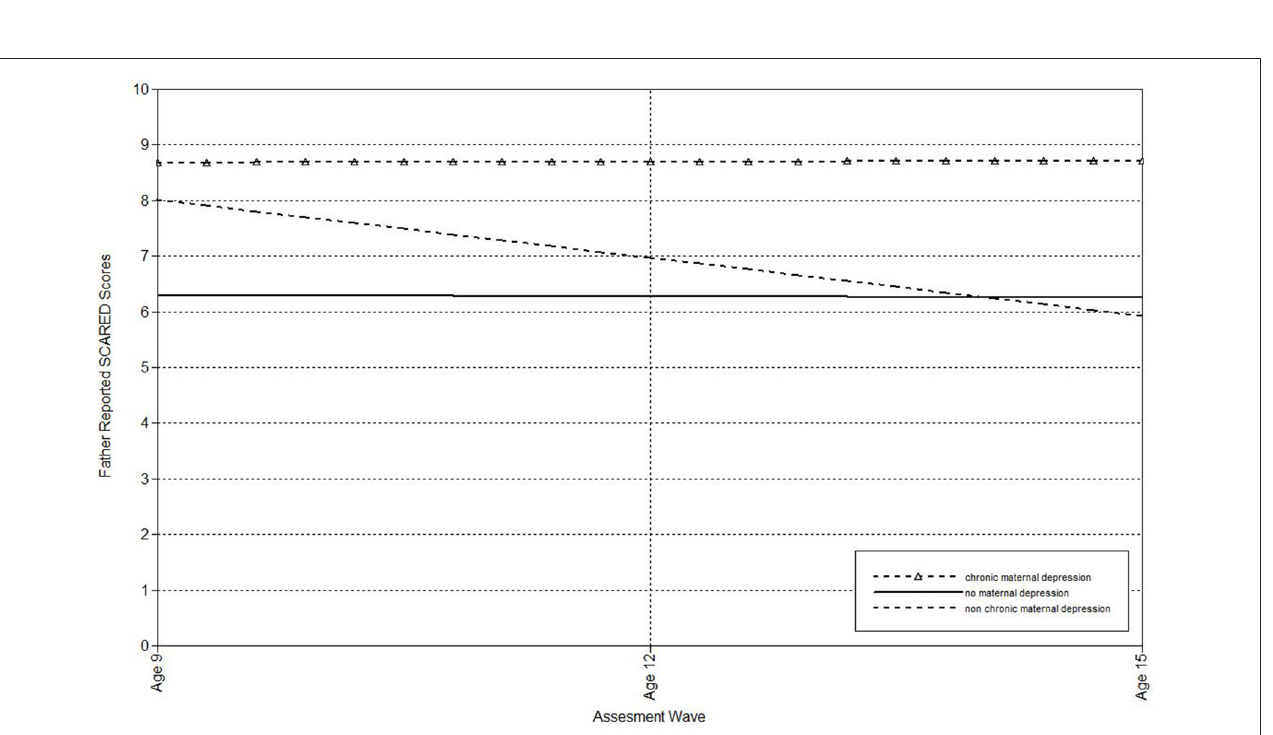
FIGURE 5 | Effect of non-chronic maternal depression (life-course perspective) on the slope of father-reported SCARED scores in offspring.